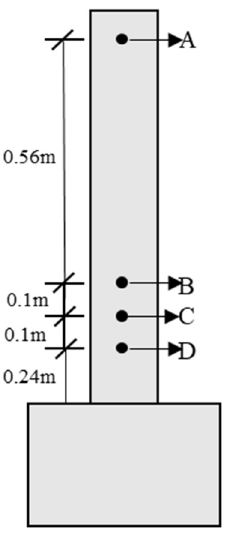
Figure 4. Layout of measuring points of the displacement meter.